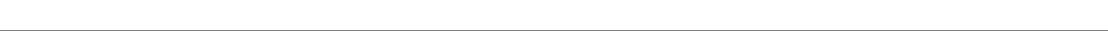
Table 4: Value of R Square Measurement of Structural Model Construct R Square Employee Performance 0,853 Organizational Citizenship Behavioral 0,872